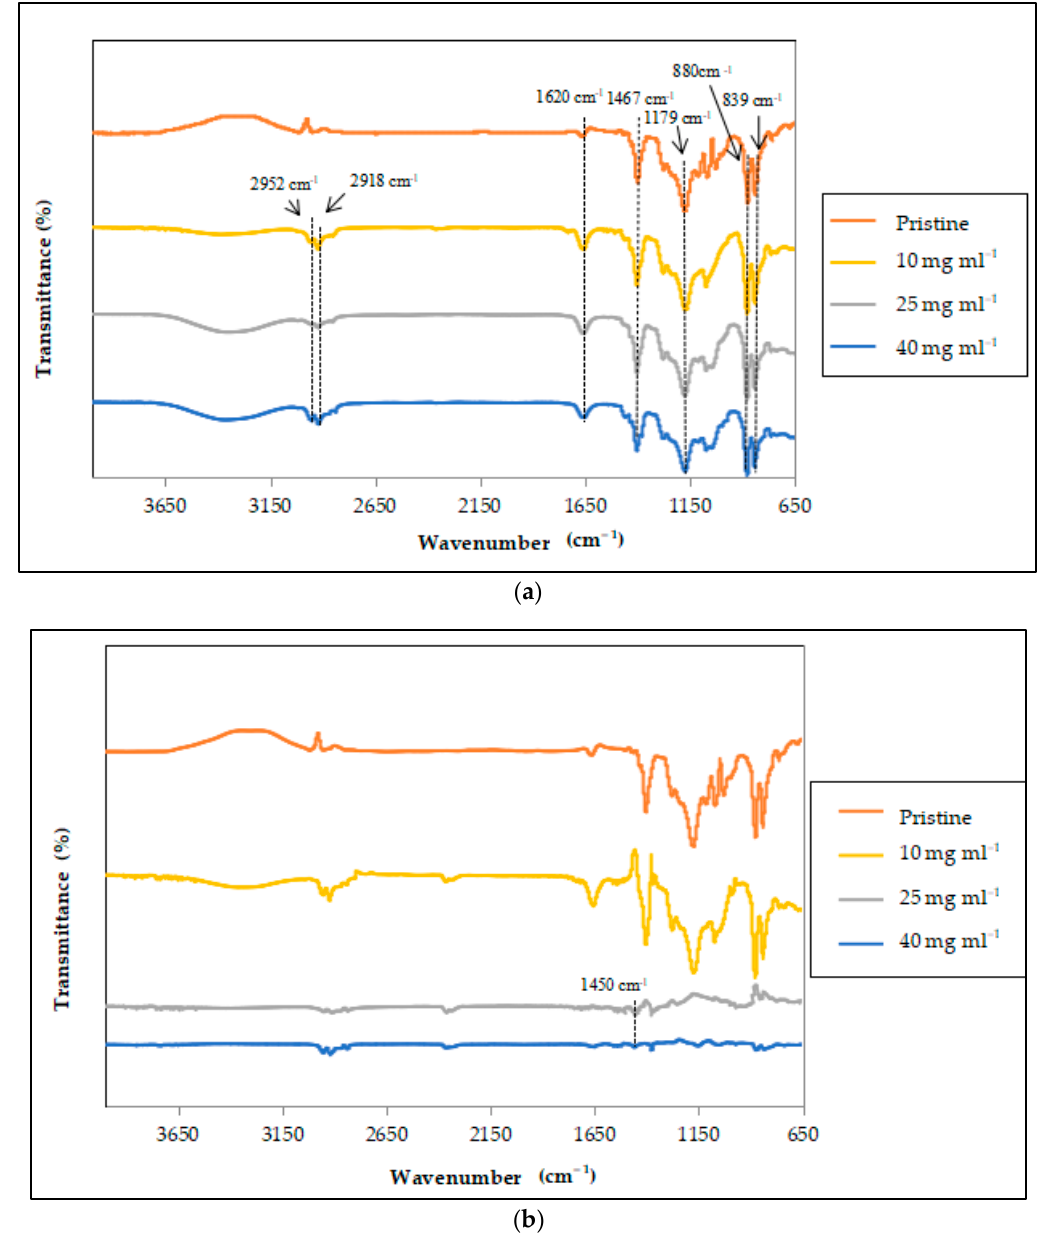
Figure 7. FTIR spectra of the modified PDVF hollow fiber membrane without MEK ( a ) and with MEK ( b ) as the non-solvent for all PP weight concentrations.